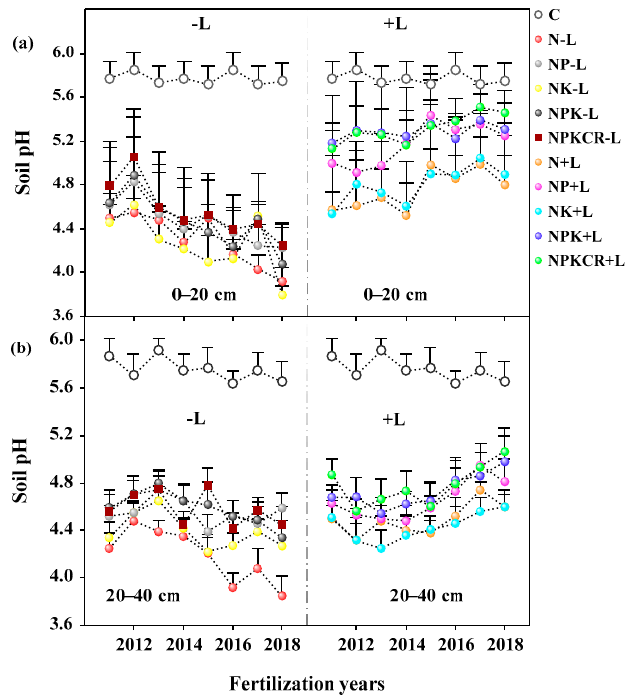
Figure 1. ( a ) Trends in soil pH in 0–20 cm; and ( b ) 20–40 cm without L ( − L) and with L (+L)